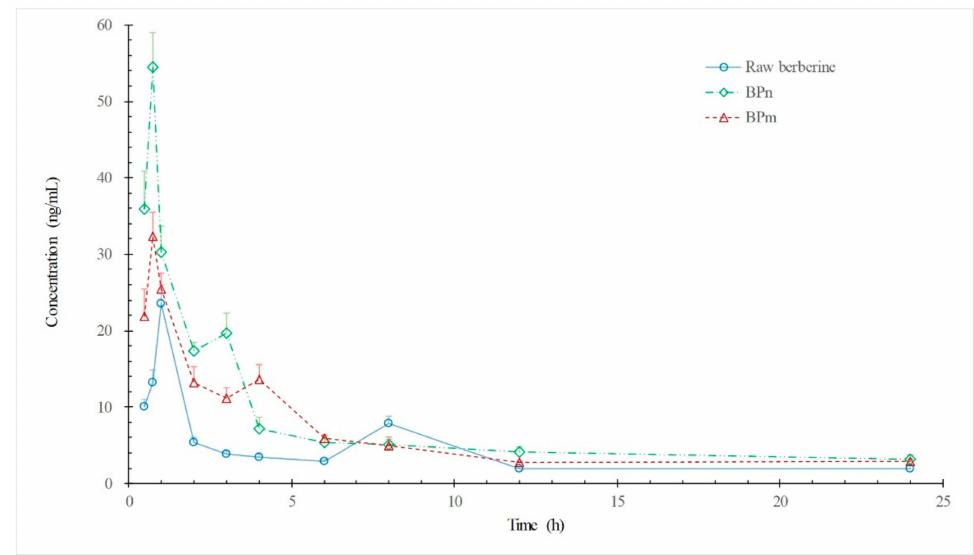
Figure 9. Plasma concentration profiles in rats after oral administrations of various formulations at a dose of 150 mg/kg. Values represent mean ± SD ( n = 5).